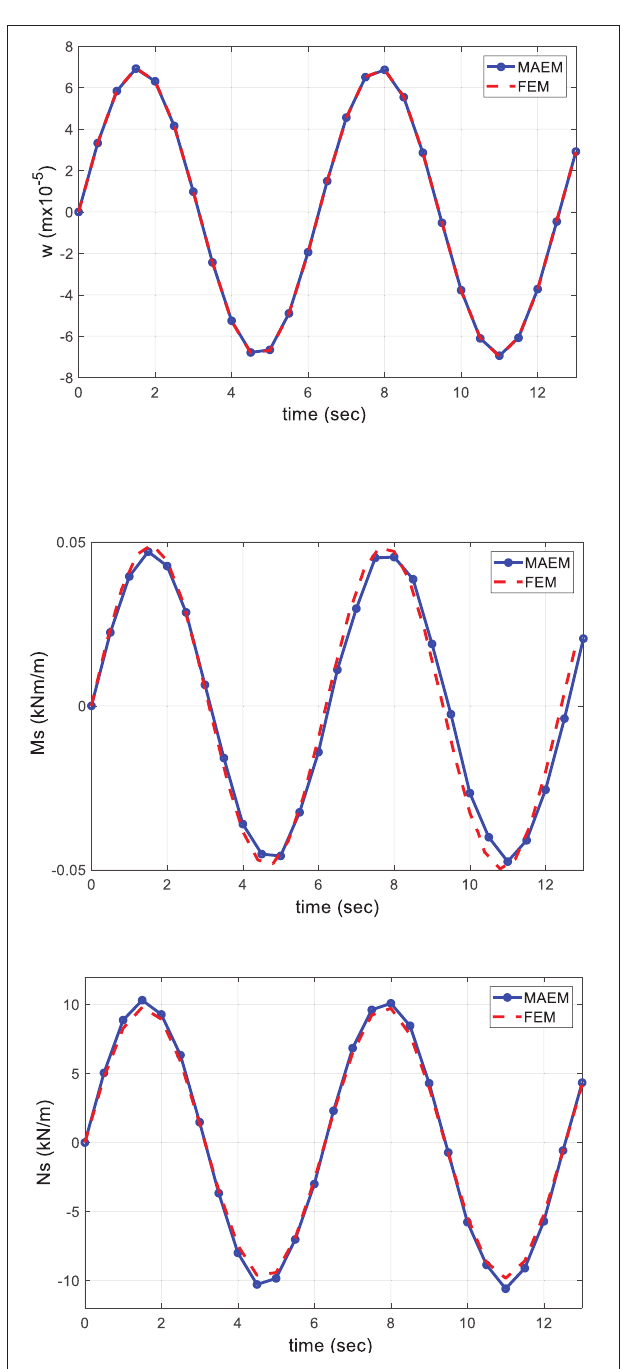
FIGURE 10 | Time history of the normal displacement w , bending moment M s , and membrane force Ns at the center of the shell in Example